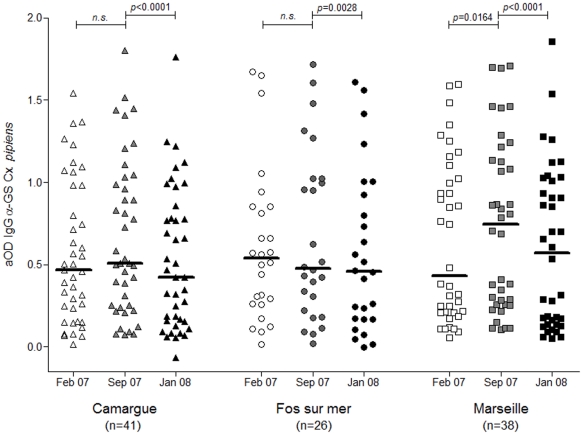
IgG serum levels anti-Cx. pipiens salivary gland protein extracts.Scatter plots of IgG antibody responses against Cx. pipiens salivary gland extracts in individuals from Marseille (squares), Fos-sur-mer (circles) and Camargue (triangles) at three times, February 07 (T1), September 07 (T2) and January 08 (T3), are represented in white, grey and black symbols, respectively. Antibody responses are represented by aOD: the mean OD value of wells with antigen minus the mean OD value of wells without antigen. Each point shows the aOD value for a single individual. Horizontal bars show medians. Differences between two sampling times at a single site were tested using the Wilcoxon signed-rank test. p-values are indicated.